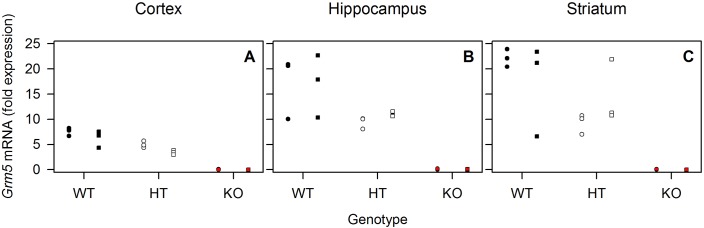
Sleep deprivation has no consistent effect on Grm5 mRNA expression in mice.qPCR of Grm5 mRNA extracted from cortex (A), hippocampus (B) and striatum (C) of n = 3 WT (black), HT (white) and KO (red) mice in sleep control (circles) and sleep deprivation conditions (squares). Individual data points are depicted. Grm5 mRNA was expressed in allele dose-dependent manner. Significant ‘genotype’ effect (F2,12 > 26.9, pall <0.0001) in two-way ANOVA with ‘genotype’ and ‘condition’ in all brain regions. No significant main effect of ‘condition’ and ‘condition’ x ‘genotype’ interaction were observed.10.7554/eLife.28751.012Figure 5—source data 1.Excel file with one data sheet containing the numerical values of each figure panel (A-C) of Figure 5.